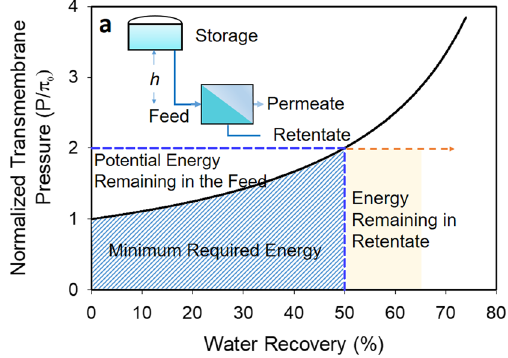
Fig. 2 Theoretical transmembrane pressure normalized to the dif- ference in the osmotic pressure of seawater and permeate for a grav- ity-driven, single-stage, constant pressure RO with 50% recovery. The inset is a representation of a seawater storage tank or reservoir h at a height 0 above the RO module. The shaded area is the ther- modynamic minimum energy requirement. For gravity-driven RO, the additional required energy shown in Fig. 1 remains as potential energy in the seawater column. The energy remaining in the pressur- ized retentate is the same as in Fig.